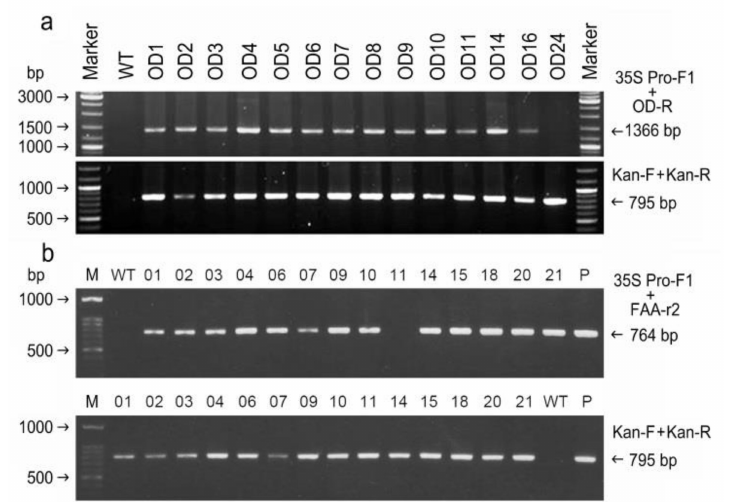
Figure 4. Verification of transgenic OD and FAA plants. ( a ) Genomic PCR analysis of transgenic OD plants. Primers 35 S Pro-F1 and OD-R were designed to detect the DNA fragment (1366 bp) of the CaMV 35 S promotor / OD region, while primers Kan-F and Kan-R were designed to detect the kanamycin resistance gene ( nptII ; 795 bp). ( b ) Genomic PCR analysis of transgenic FAA plants. Primers 35 S Pro-F1 and FAA-r2 were designed to detect the DNA fragment (764 bp) of the CaMV 35 S promotor / FAA region, while primers Kan-F and Kan-R were designed to detect the nptII gene (795 bp).